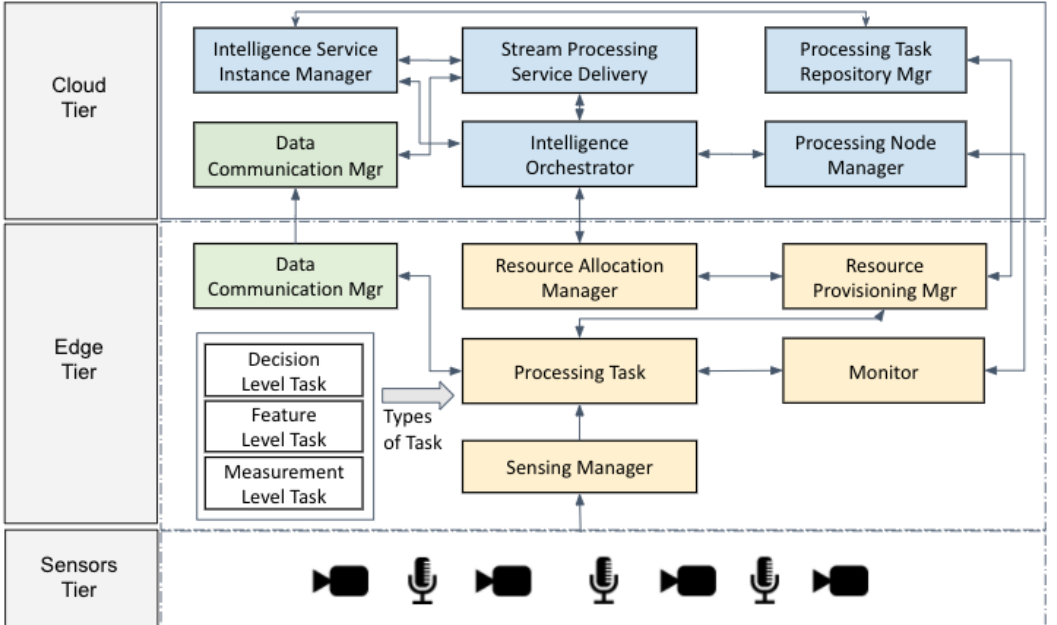
Figure 3. MELINDA software components